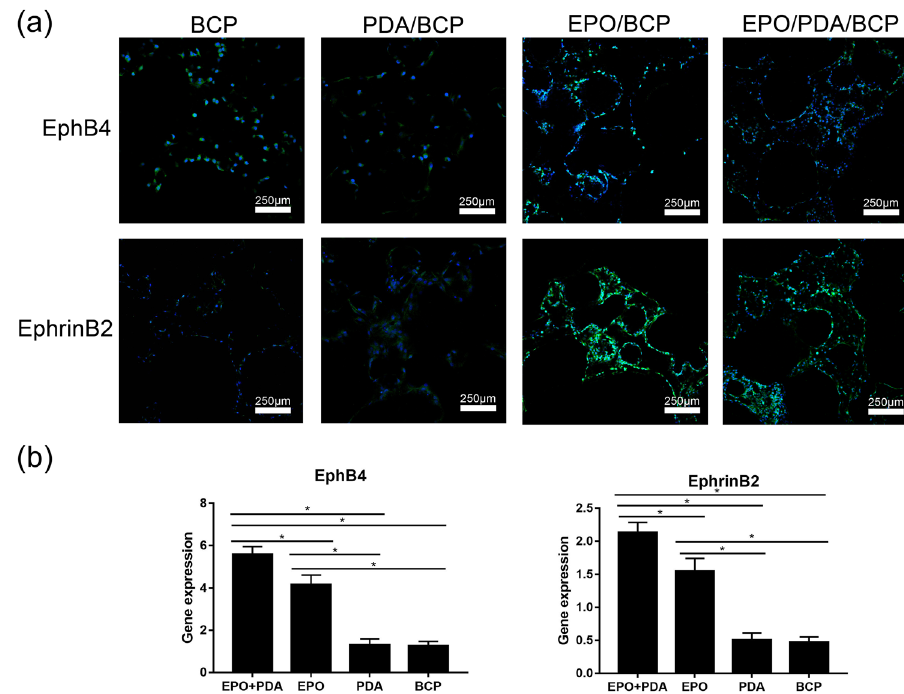
Fig. 7 a Immuno fl uorescent staining showed the expression of EphB4/EphrinB2 signaling pathways of co-cultured cells on different BCP bioceramics on day 7. b The quantitative analysis of the immuno fl uorescent